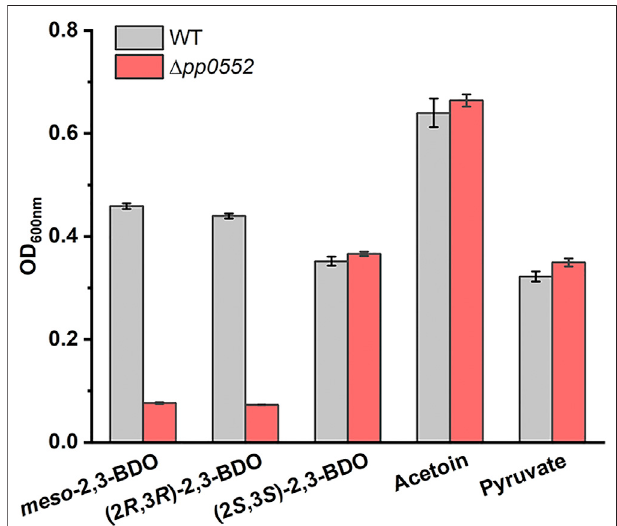
FIGURE4| Identi fi cationofthephysiologicalfunctionof R , R -BDHin2,3- BDO catabolism. P. putida KT2440 and P. putida KT2440 ( Δ pp0552 )